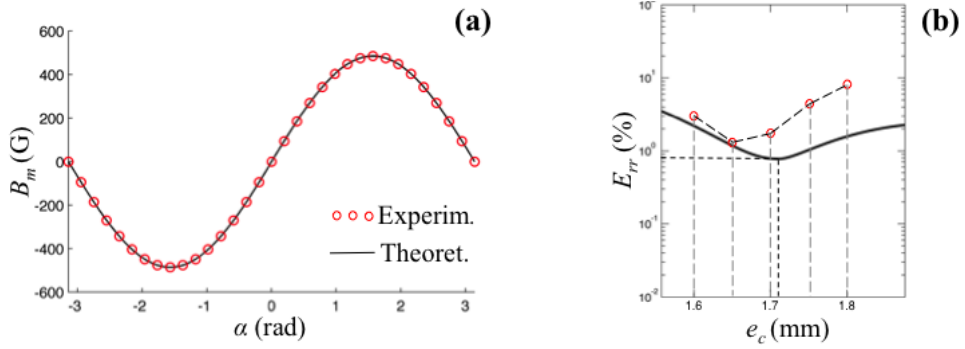
Figure 9. Plot of the experimental results ( ) ( a ) comparison between theoretical and experimental values of the measured induction field ( b ) comparison between theoretical and experimental optimal